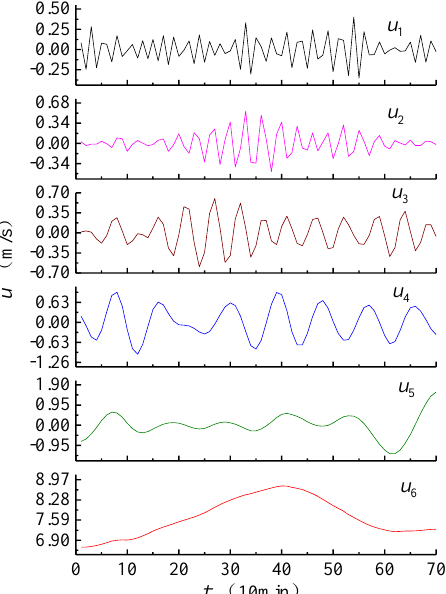
Figure 10. Ensemble empirical mode decomposition results of the first 70 points of the wind speed series. Analyzing the characteristics of each component of EVMD and EEMD, the highest frequency component’s amplitude in EV MD is between [ −0 .35, 0.40], with a component mean of −0.01, and the highest frequency component’s amplitude in EEMD is between [ −0 .93, 0.83], with a component mean of 0.03. Compared with EEMD, it is evident that EVMD decomposes the high-frequency component more completely. When the wave- forms of the lowest frequency component generated by the two approaches are compared, the lowest frequency component of EVMD can better depict the long-term fluctuation fea- tures of the wind speed.